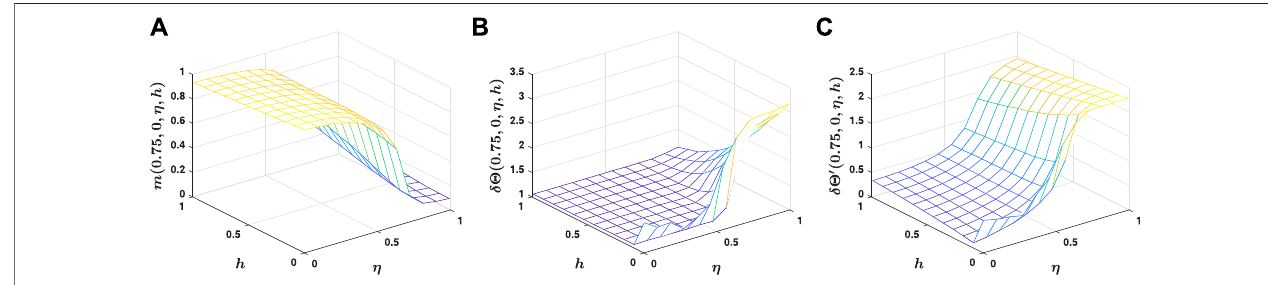
FIGURE 2 | Different phases of the system. From (A) to (C) , respectively, m ( 0 . 75 , 0 , η , h ) , δ Θ ( 0 . 75 , 0 , η , h ) , and δ Θ ’ ( 0 . 75 , 0 , η , h ) in the η − h plane are plotted. For low communication noise η , collective motion emerges. As noise increases, the system settles in the disordered phase. The collective motion phase is composed of an informedcollectivemotion phase, whenthefraction ofinformedindividuals h islarge,and a misinformedcollectivemotion phase,when h issmall.Here, L (cid:2) 10, v 0 (cid:2) 0 .